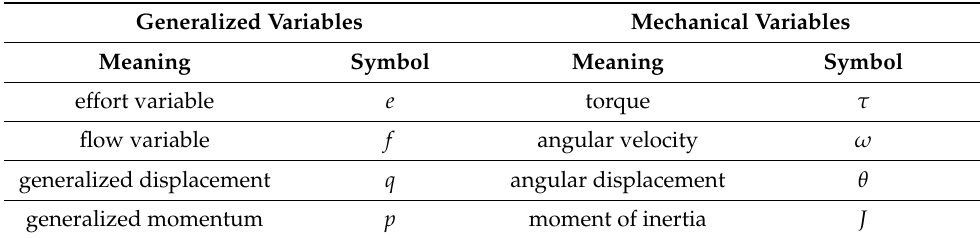
Table 1. Correspondence between mechanical variables and generalized variables.